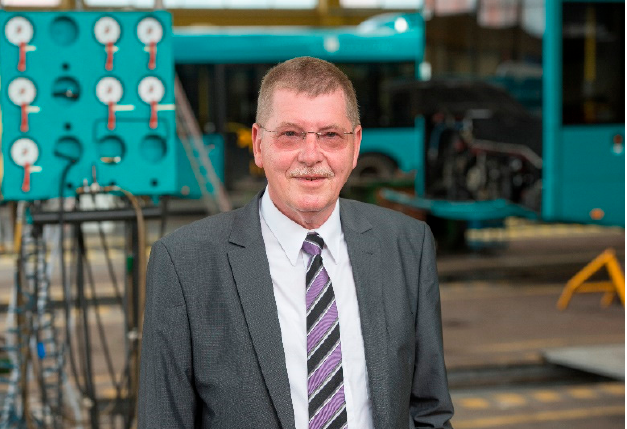
Figure 1. Walter Lachenmeier in July 2014 at an electric bus workshop (kindly provided by the estate of Walter Lachenmeier with permission of the heirs).